Question: Describe this figure in one sentence.
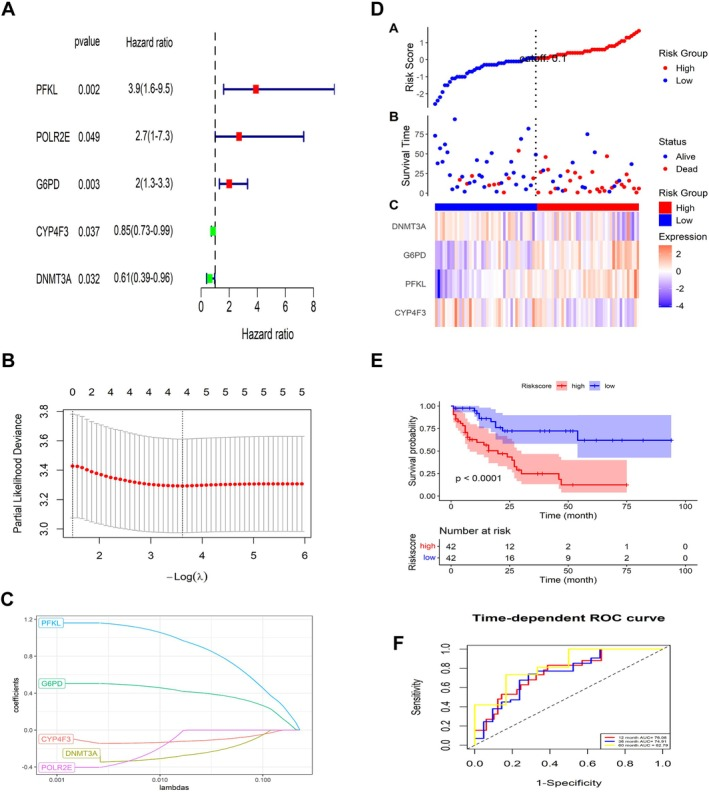
Answer: Development and validation of a metabolic‐related prognostic signature in AML. (A) Univariable Cox regression analysis in the TCGA‐LAML training cohort identified genes significantly associated with OS ( p < 0.05), which were retained as candidates for model construction. (B) LASSO Cox regression was applied to reduce dimensionality and prevent overfitting; coefficient trajectories across log(λ) illustrate the shrinkage and selection process. (C) Ten‐fold cross‐validation was used to determine the optimal λ value based on the minimum partial likelihood deviance and the 1‐standard‐error criterion. (D) The relationship between the expression of four metabolic signatures and risk score, overall survival, and living status. (E) Kaplan–Meier survival analysis showed significantly poorer OS in the high‐risk group compared with the low‐risk group. (F) Time‐dependent ROC curves at 12, 36, and 60 months demonstrated the predictive performance and stability of the risk model. AML, acute myeloid leukemia; LASSO, least absolute shrinkage and selection operator; OS, overall survival; ROC, receiver operating characteristic; TCGA, The Cancer Genome Atlas.